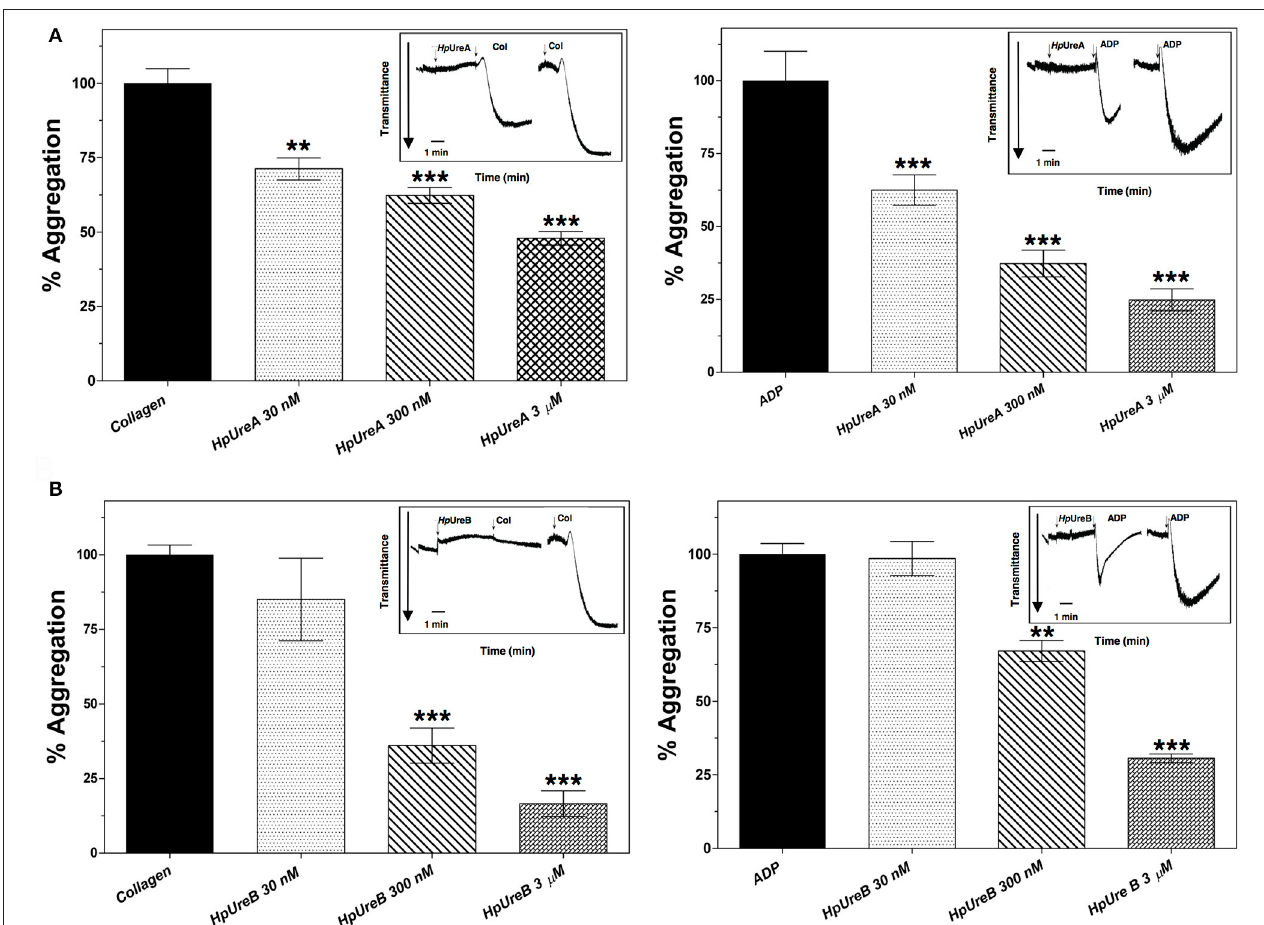
FIGURE 2 | HPU isolated subunits interfere on platelet aggregation triggered by collagen or ADP. Pretreatment with HpUreA (A) or HpUreB (B) interferes in a dose-dependent manner on the response of rabbit platelets to the physiological agonists collagen (left panels) and ADP (right panels). Platelets were pre-incubated for 5min at 37 ◦ C without stirring with increasing concentrations of HpUreA or HpUreB. Aggregation was then triggered with collagen (50 µ g.mL − 1 ) or 10 µ M ADP. The results are expressed as a percentage of maximum aggregation produced by collagen or ADP. Aggregation was monitored in a plate reader SpectraMax ® M3 (Molecular Devices), with readings every 11s for 20min at 650nm. Typical recordings of the aggregation responses are shown in the insets. In all panels, the aggregation responses were quantified as area under the tracings using SoftMax Pro 5.4.1. Data are expressed as means ± SEM. Statistical significance was determined by ANOVA followed by Tukey-Kramer test. Values of ** p < 0.01, *** p <